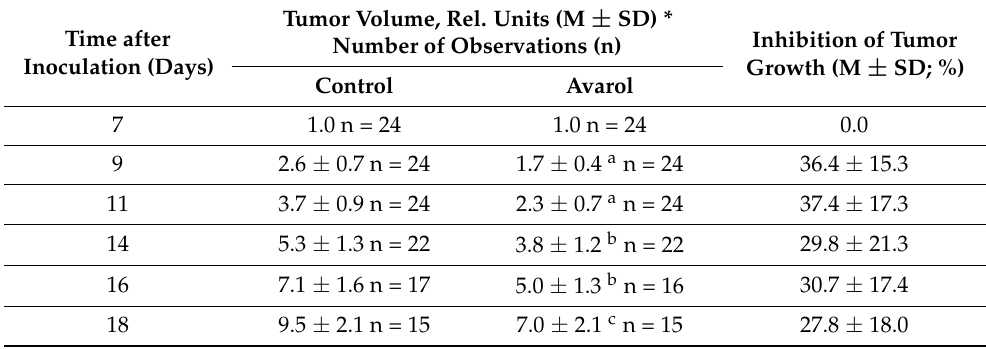
Table 4. The influence of avarol (50 mg/kg i.p. daily) on the dynamics of CC-5 growth in female CBA mice. Tumor Volume, Rel. Units (M ± SD) * Time after Inoculation (Days)